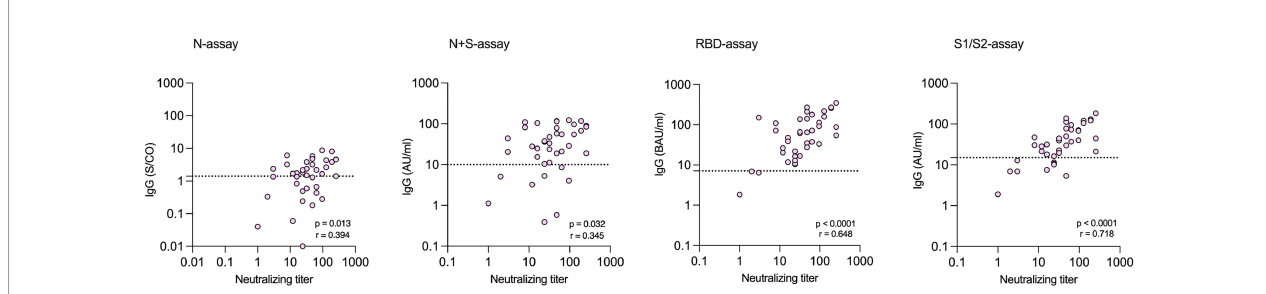
FIGURE 4 | Correlations between levels of neutralizing antibodies (NAbs) and levels of SARS-CoV-2 speci fi c IgG measured at time-point 4 by commercial assays among health care workers with veri fi ed infection. Dotted lines indicate the cut-off for positivity in each commercial IgG-assay.